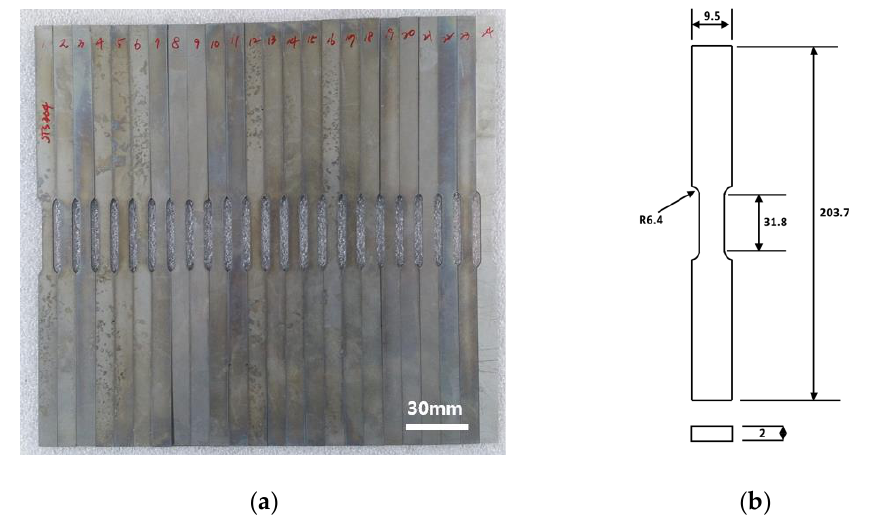
Figure 1. ( a ) Test specimens and ( b ) specimen geometry (dimensions are in mm).